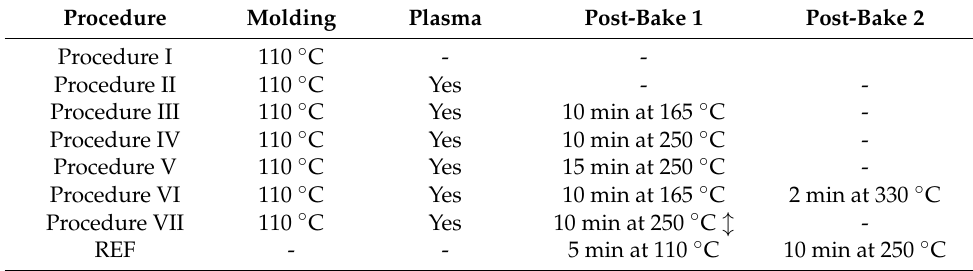
The (cid:108) symbol indicates flipping of the The ↕ symbol indicates flipping of the sample.